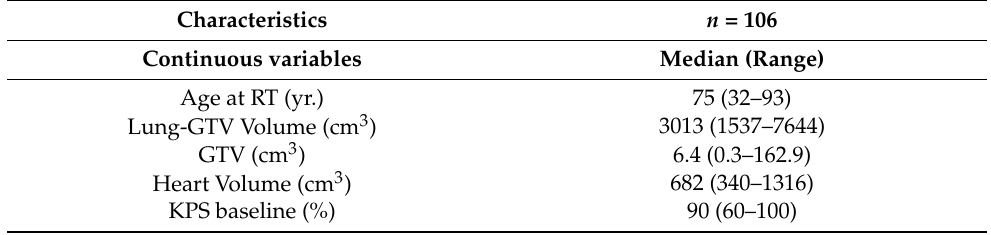
Table 1. Patient and treatment